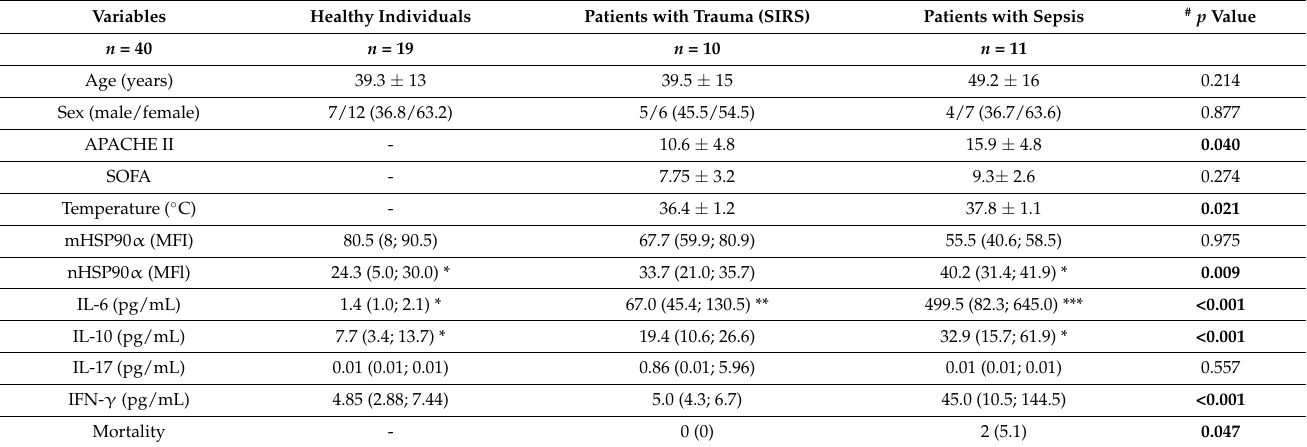
Table 1. Demographic and clinical characteristics.